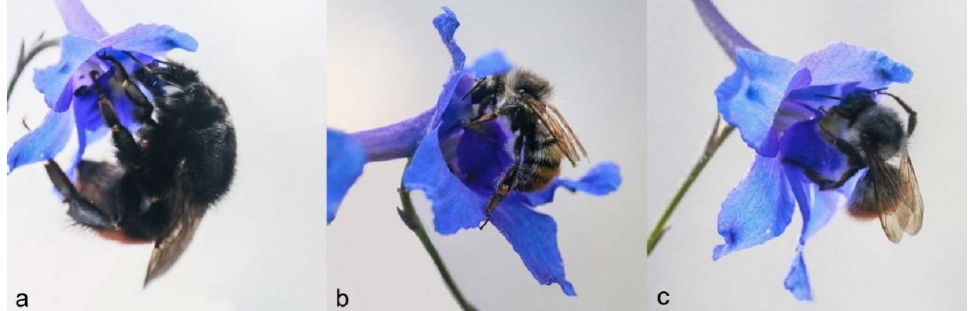
Figure 4. The visitors of D. caeruleum in Gannan. ( a ) B. pyrosoma . ( b ) B. impetuosus . ( c ) B. lepidus .